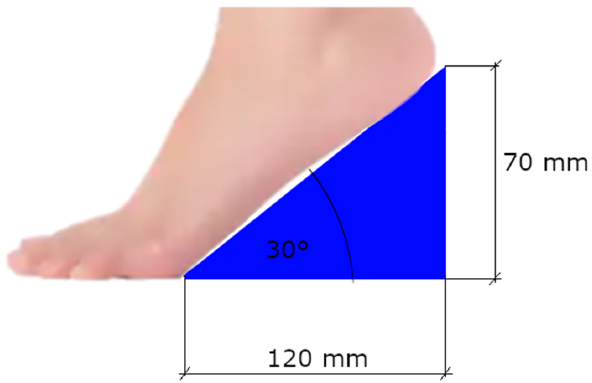
Figure 3. Schematic view of the wedge used as the heel with dimensions. The maximum height of the wedge was slightly larger than the heel effect it had on the foot.